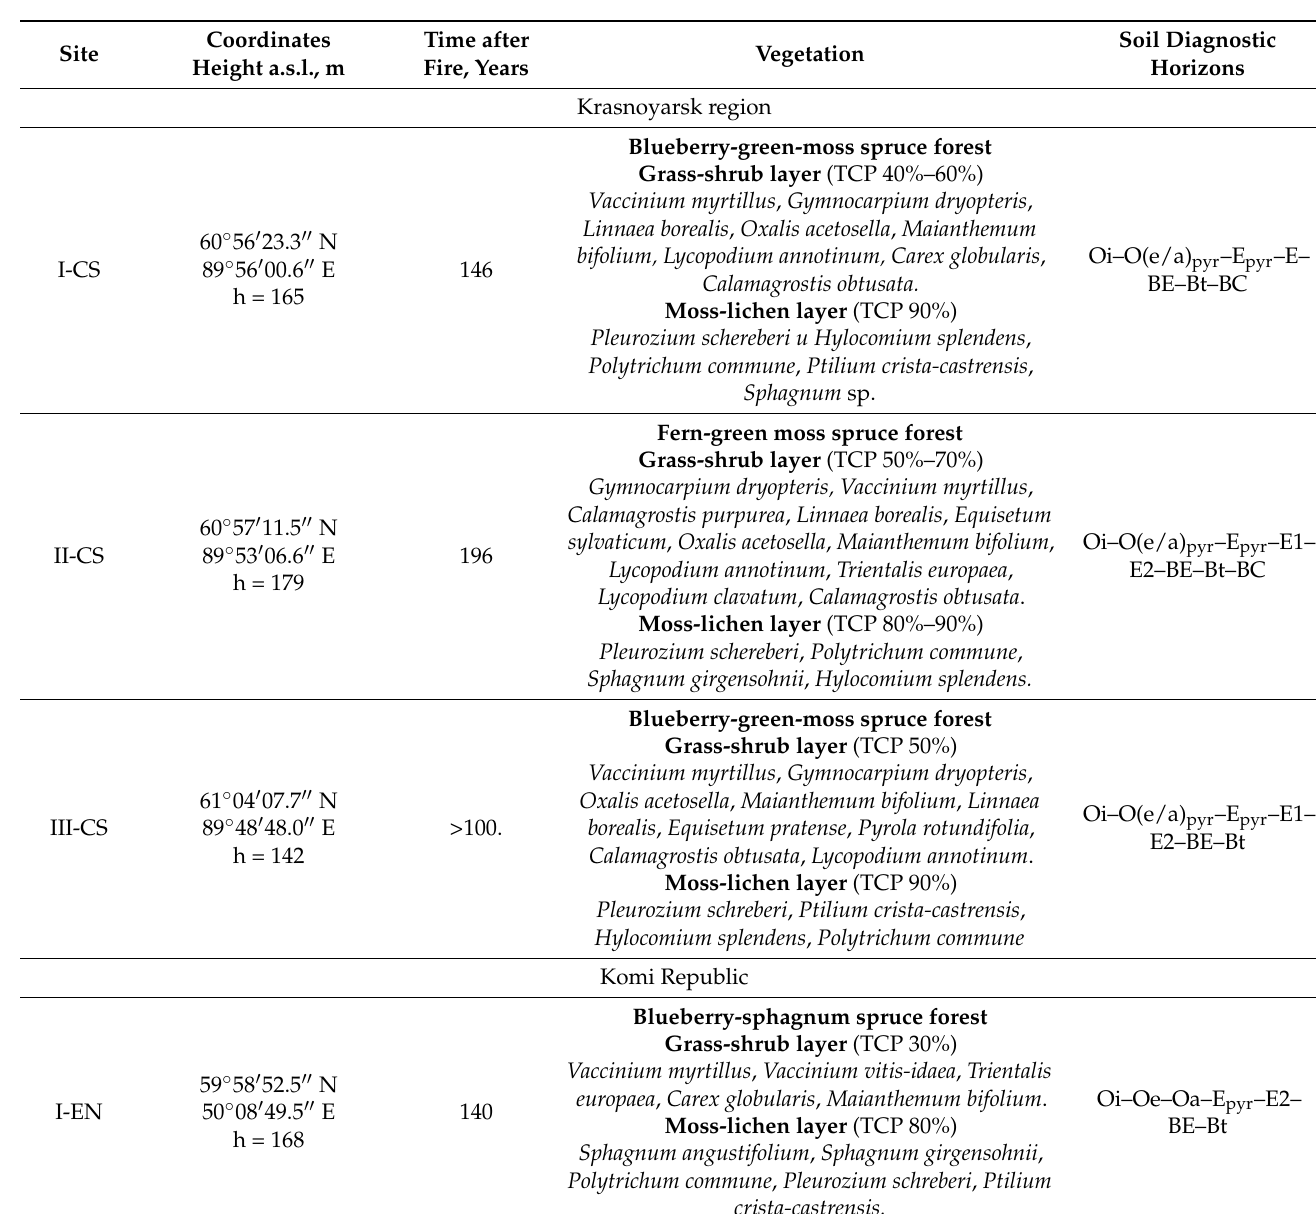
Table 1. Description of the objects of